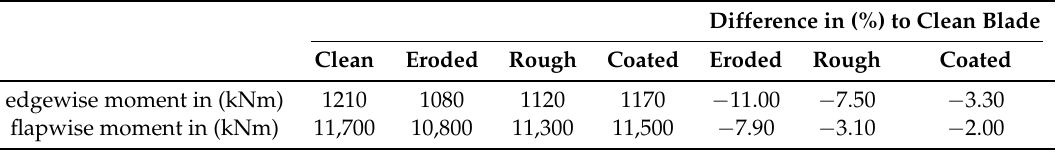
Table 5. Comparison of the edgewise and flapwise root bending moments using different sets of polars at rated conditions (reference is the clean blade).